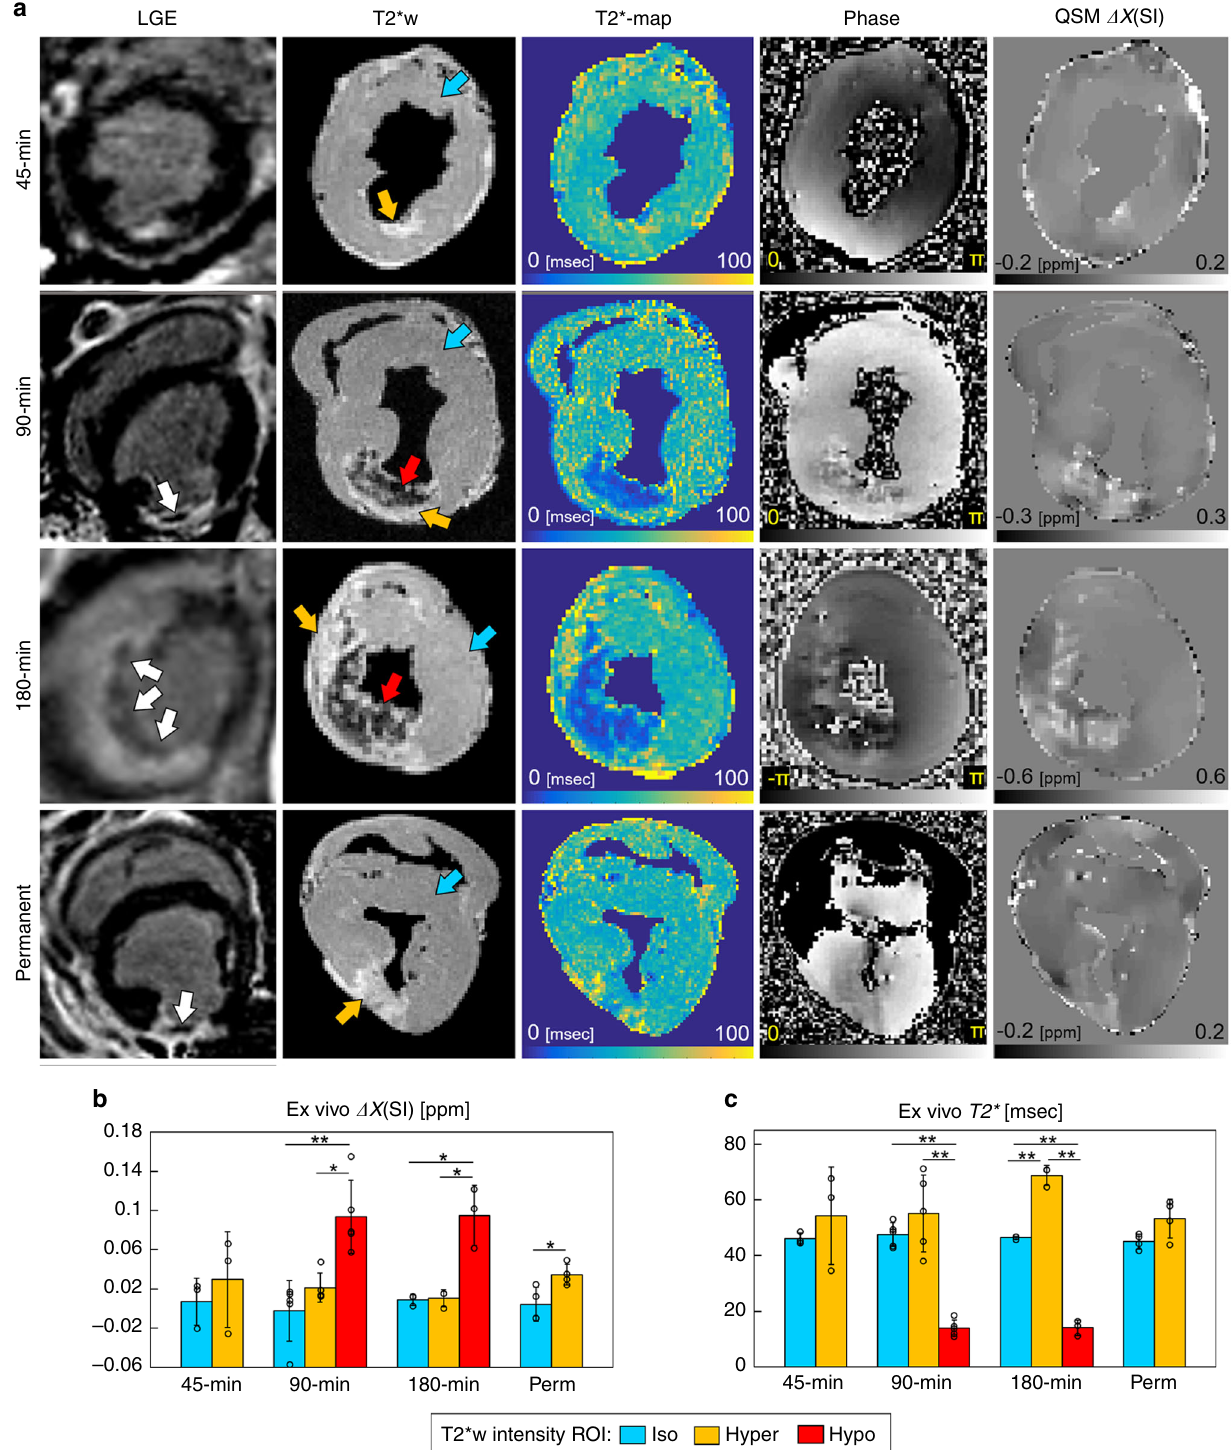
remote myocardium compared with T2 * and R2 *